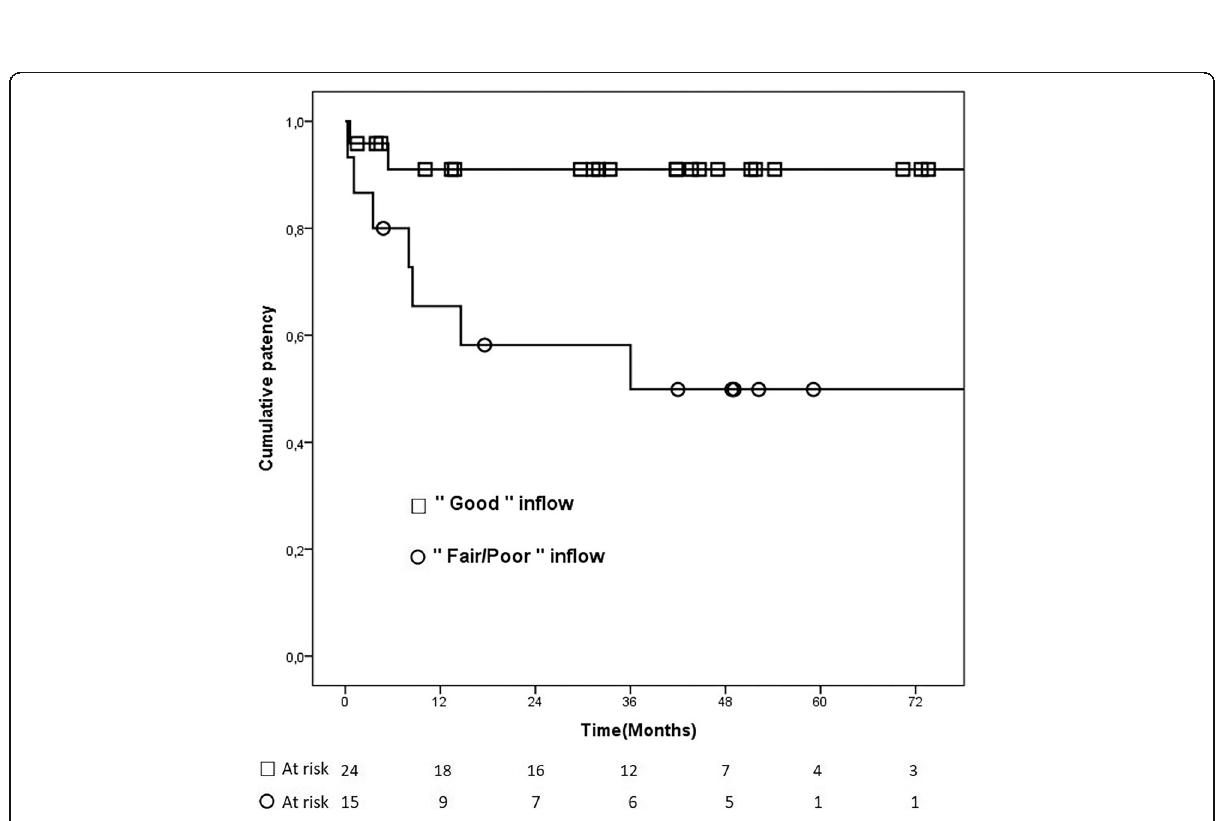
Fig. 5 Cumulative primary patency in patients classified with “ good ” inflow ( □ ) versus “ fair/poor ” inflow ( ○ ) ( p =